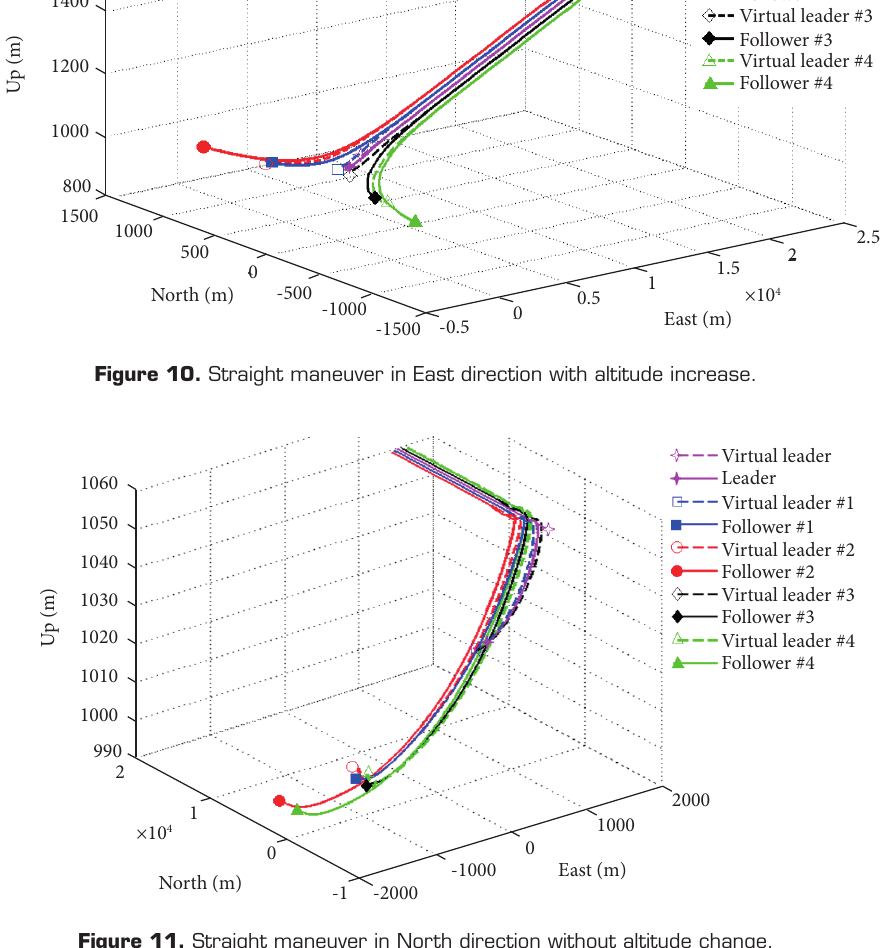
Figure 11. Straight maneuver in North direction without altitude